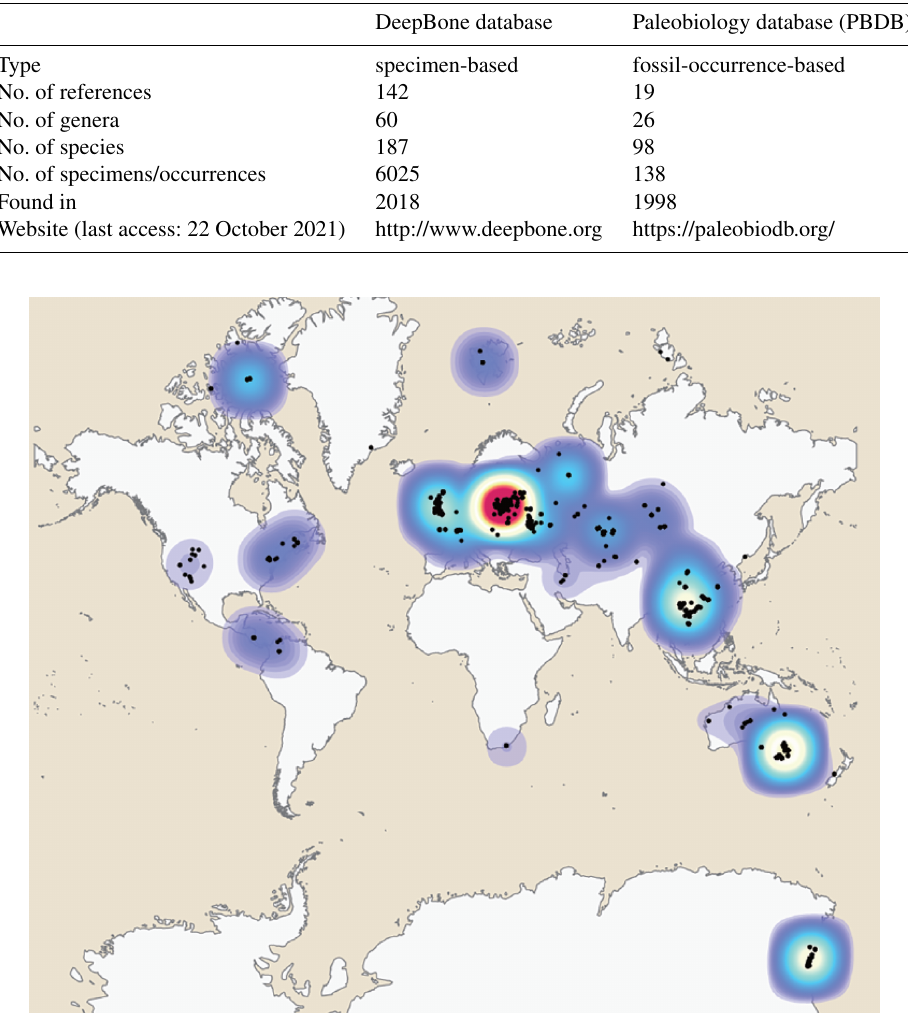
Figure 5. Heat map of Antiarcha fossil sites based on the modern world map. Each spot represents a single fossil site. The blue color indicates the area with sparse fossil sites. The red color indicates the area with dense fossil